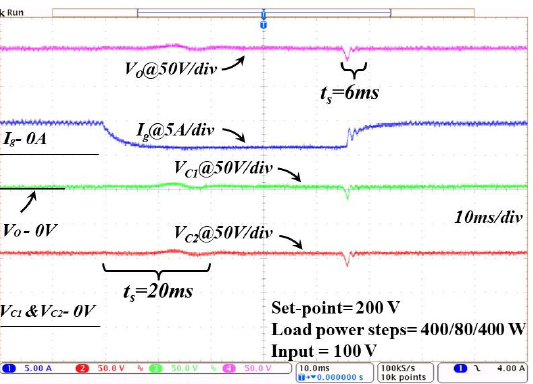
Figure 28. Closed-loop test in which the output power Po changes from 400 W to 80 W , and then it increases back to 400 W again, Vo is regulated to 200 V . and then increased back (from 85 V to 100 V ), the output voltage is well regulated.